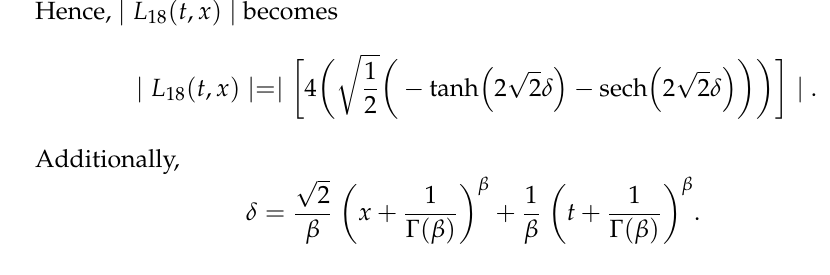
Figure 7: This illustration portrays a realistic representation of | L 18 ( t , x ) | which is linked to the category of dark–bright solitary-wave solutions. Here is a visual showing a 3D plot spanning the range ( − 0.8, 0.8 ) for various values of β associated with parameters, √ such as ρ = e , l = 2, c = 1, α = − 1, s 1 = 1 , µ 1 = − 1, ζ 1 = 2, ν 1 = 0, m = − 1, n = 1, 2 β =